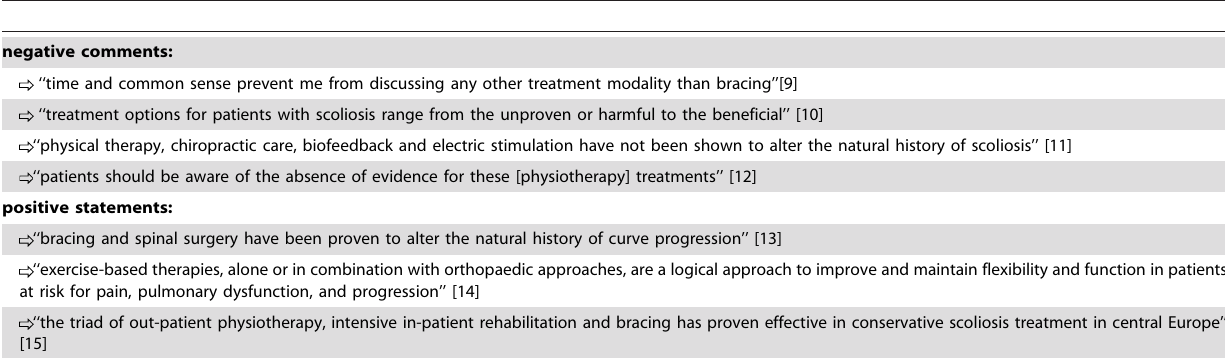
Table 1. Opinions regarding non-surgical interventions for adolescents with idiopathic scoliosis.